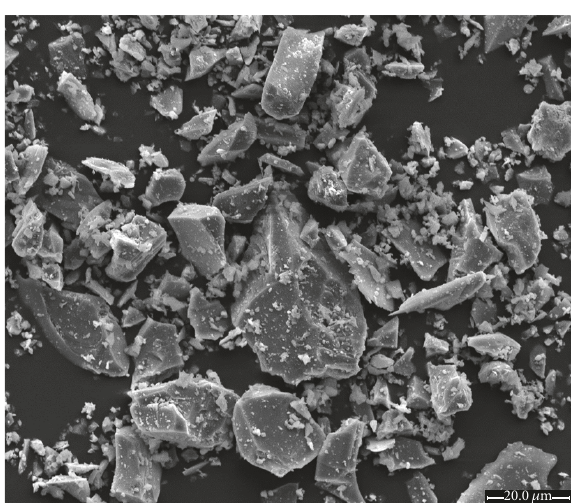
Figure 1: Scanning electron microscope image of the phosphorus slag.